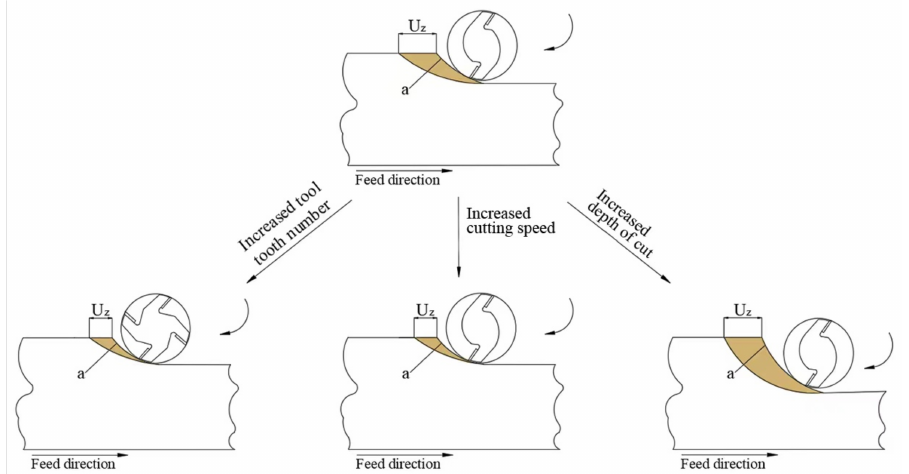
Figure 5. Changes in cutting quantities under different